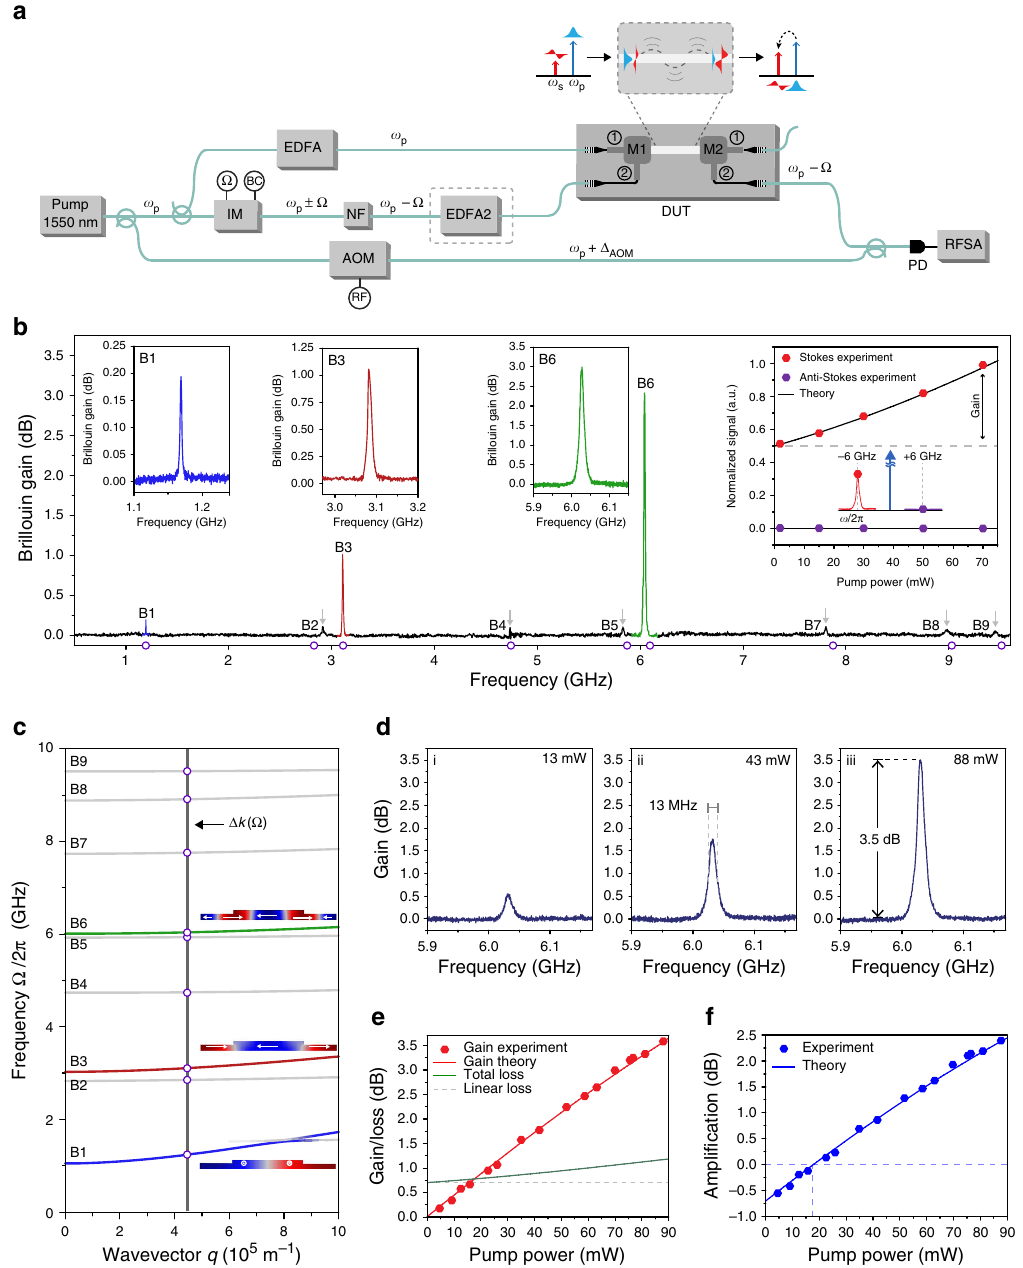
Figure 3 | Experimental results showing on-chip SIMS and net optical amplification. ( a ) Diagram of the experimental apparatus. A laser operating around 1,550nm is used to synthesize a strong pump wave through an EDFA while a separate branch is passed through an intensity modulator and notch filter to generate a frequency-shifted probe wave. An additional EDFA, denoted EDFA2, is inserted later for the optical energy transfer experiment. Pump and probe waves couple in and out of the device through mode multiplexers. After the device, the probe wave is combined with a frequency-shifted reference arm, and its intensity is measured via heterodyne detection. ( b ) SIMS spectra over a 9GHz span showing several Brillouin-active acoustic modes, with three highlighted and plotted in more detail in insets. Simulated frequencies from multi-physics simulations are denoted by violet circles along the abscissa. A fourth inset shows single-sideband gain as a function of pump power when driving acoustic resonance B6—note that while Stokes light experiences gain, no light is scattered to the anti-Stokes order. A data trace at high pump power is included schematically, showing single-sideband gain as the probe wave is swept through the Brillouin resonance. Red and purple dots correspond to the measured gain when driven on-resonance. ( c ) Calculated dispersion curves for the observed Brillouin-active acoustic modes. Displacement is diagrammed for modes B1, B3 and B6 next to their respective curves. The vertical gray line plots the wavevector of Brillouin-active phonons under the conditions tested. ( d – f ) show Brillouin gain and amplification data for the strongest Brillouin-active mode B6. ( d i–iii) Plot inter-modal Brillouin gain spectra obtained for three different pump powers. These data show a narrowband Brillouin resonance at 6.03GHz. ( e ) plots peak gain (red), linear loss (dash) and total loss (green) versus on-chip pump power. ( f ) Net on-chip amplification from ( e ), obtained by subtracting total loss from optical gain. These data are measured with the pump wave in the symmetric optical mode and the probe wave in the anti-symmetric mode. IM, Mach–Zehnder intensity modulator; BC, DC bias controller, EDFA, erbium-doped fibre amplifier; NF, notch filter; DUT, device under test; AOM, acousto-optic frequency shifter; PD, photodetector; RFSA, radio-frequency spectrum